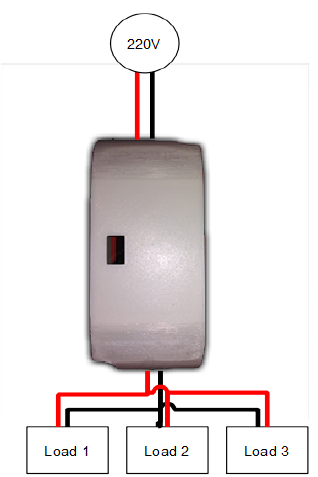
Figure 2. Sensor data monitoring test circuit